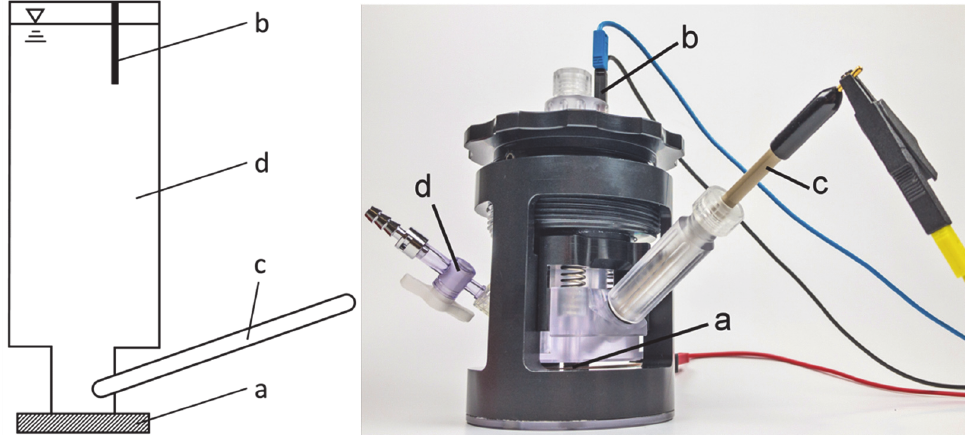
Figure 2. EIS cell; ( left ): schematic; ( right ): photo of the cell; (a) working electrode, (b) counter electrode, (c) reference electrode and (d) electrolyte inlet.